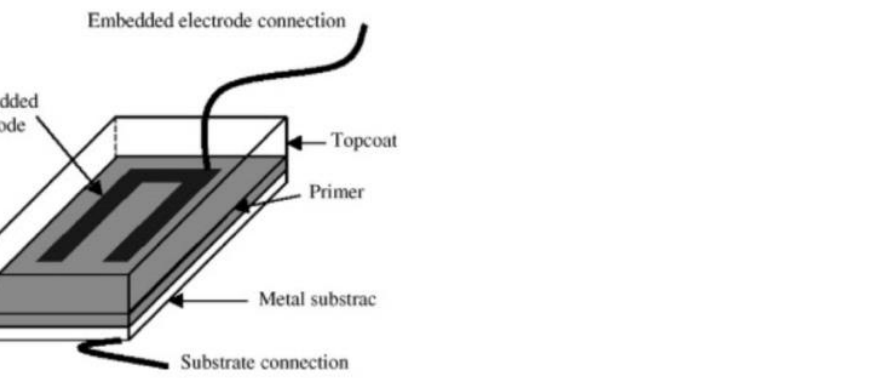
Figure 13. An illustration of electrodes embedded in Pt coating for ENM measurement. Reprinted with permission from ref. [95]. Elsevier, 2008.